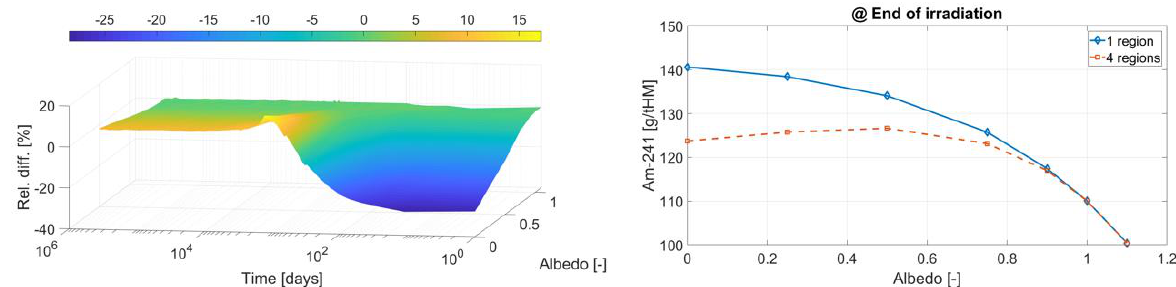
Figure 9. Differences in 241 Am concentration between 1 region and 4 region cases as a function of albedo and irradiation + subsequent cooling time.